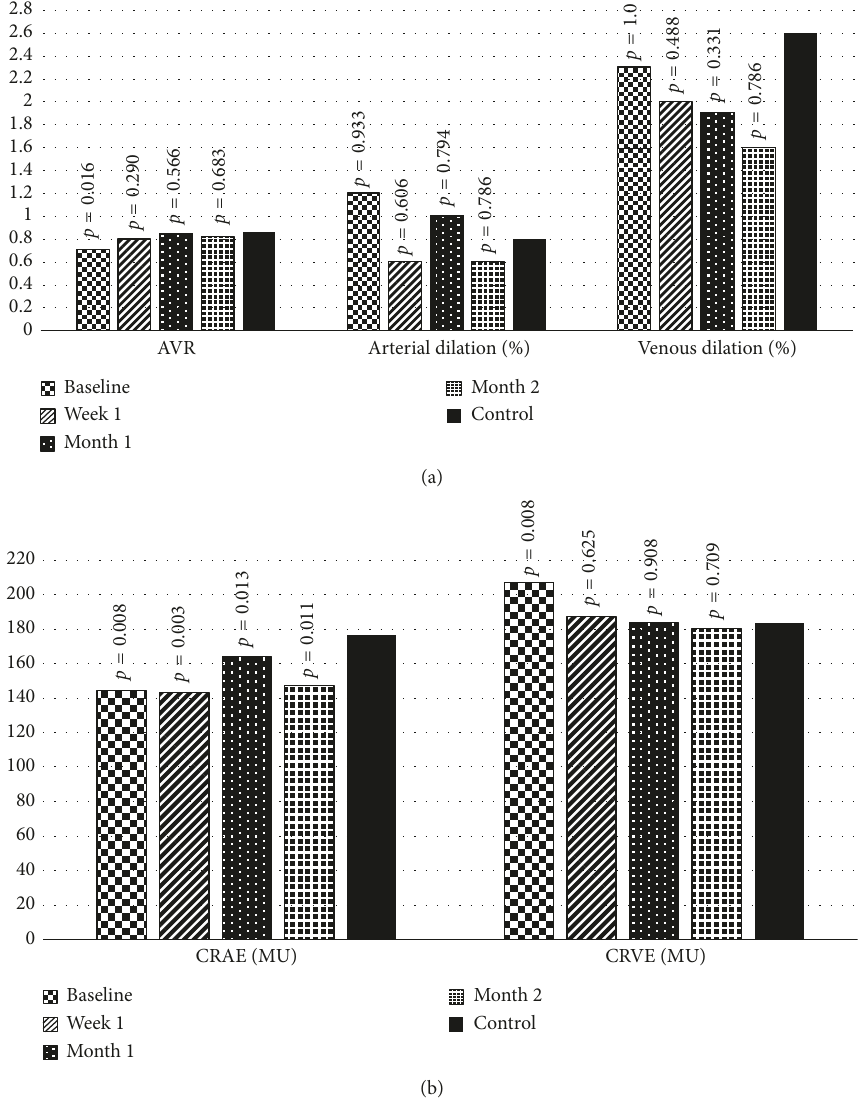
arteriovenous ratio; CRAE central (cid:31) (cid:31) measurement units; values are expressed as mean standard (cid:31) ±